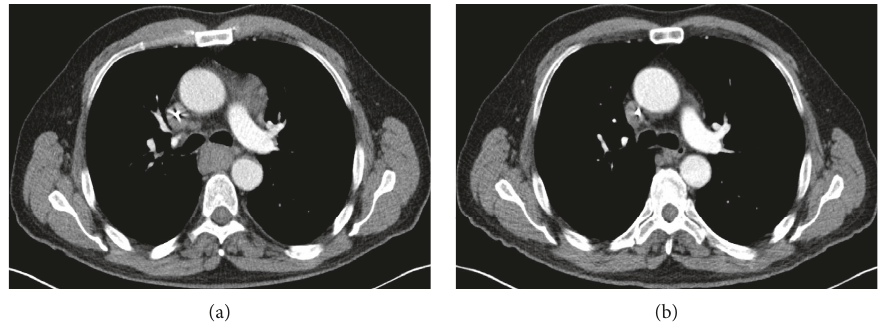
Figure 3: Computed tomography (CT) scan of the chest with contrast before and after nivolumab. (a) CTchest before initiation of nivolumab; an axial image depicting significant mediastinal and right hilar lymphadenopathy. (b) CT chest after 12 cycles of nivolumab; no hilar or mediastinal lymphadenopathy